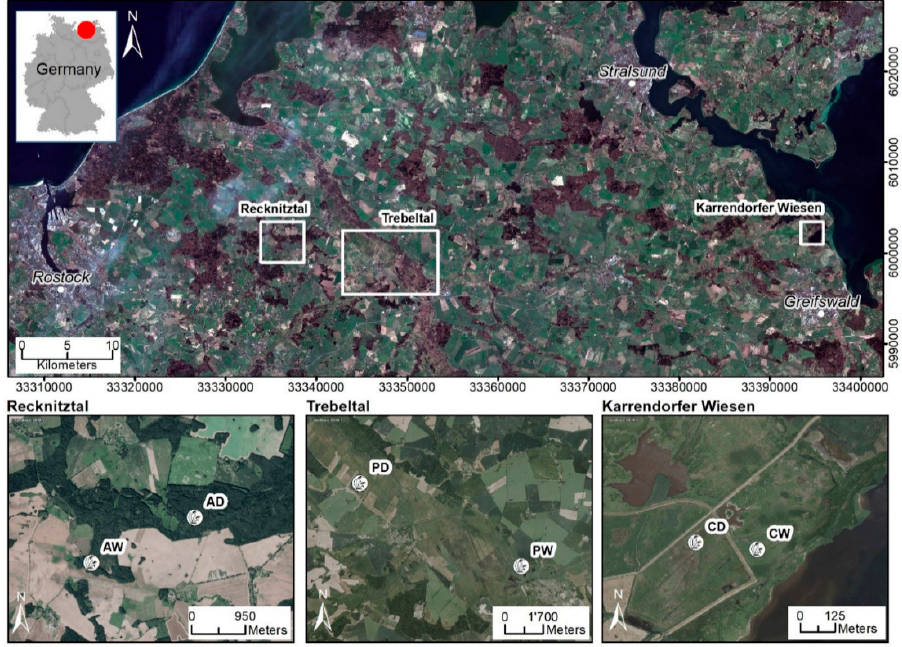
Figure 1. Overview of the six sampling sites: Alder dry (AD), Alder wet (AW), Coast dry (CD), Coast wet (CW), Perco dry (PD), and Perco wet (PW).